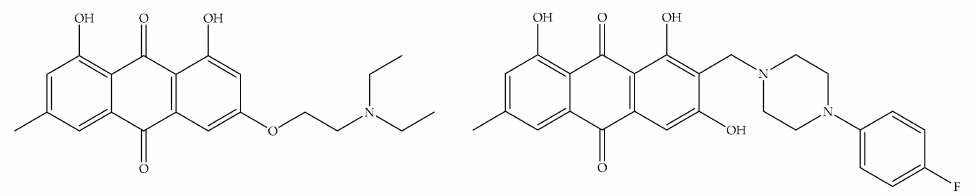
Figure 10. Chemical structure of new emodin derivatives I and